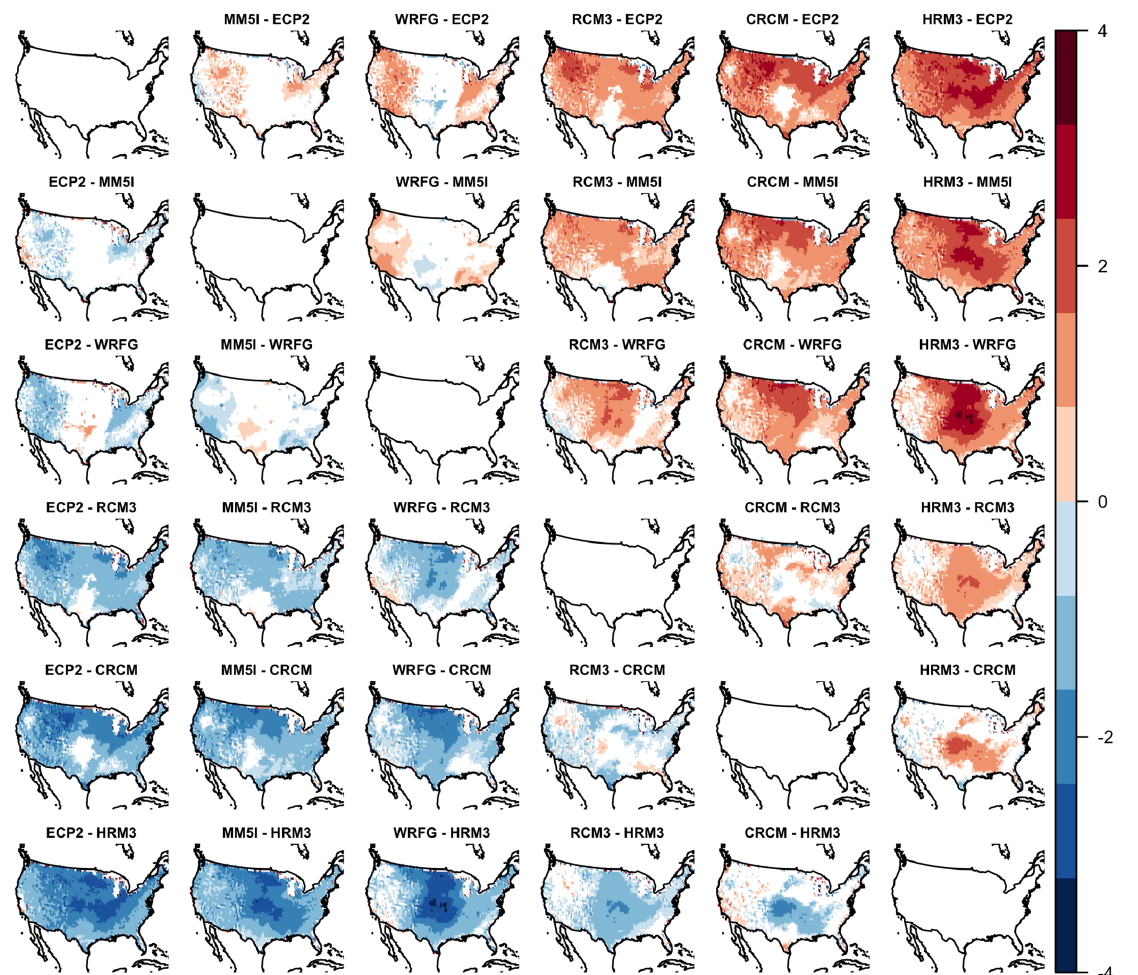
Figure 6. A heat map of the estimated average pairwise differences in RCM effect for the APL model. Only significant locations at the 0.10 level using pointwise inference are